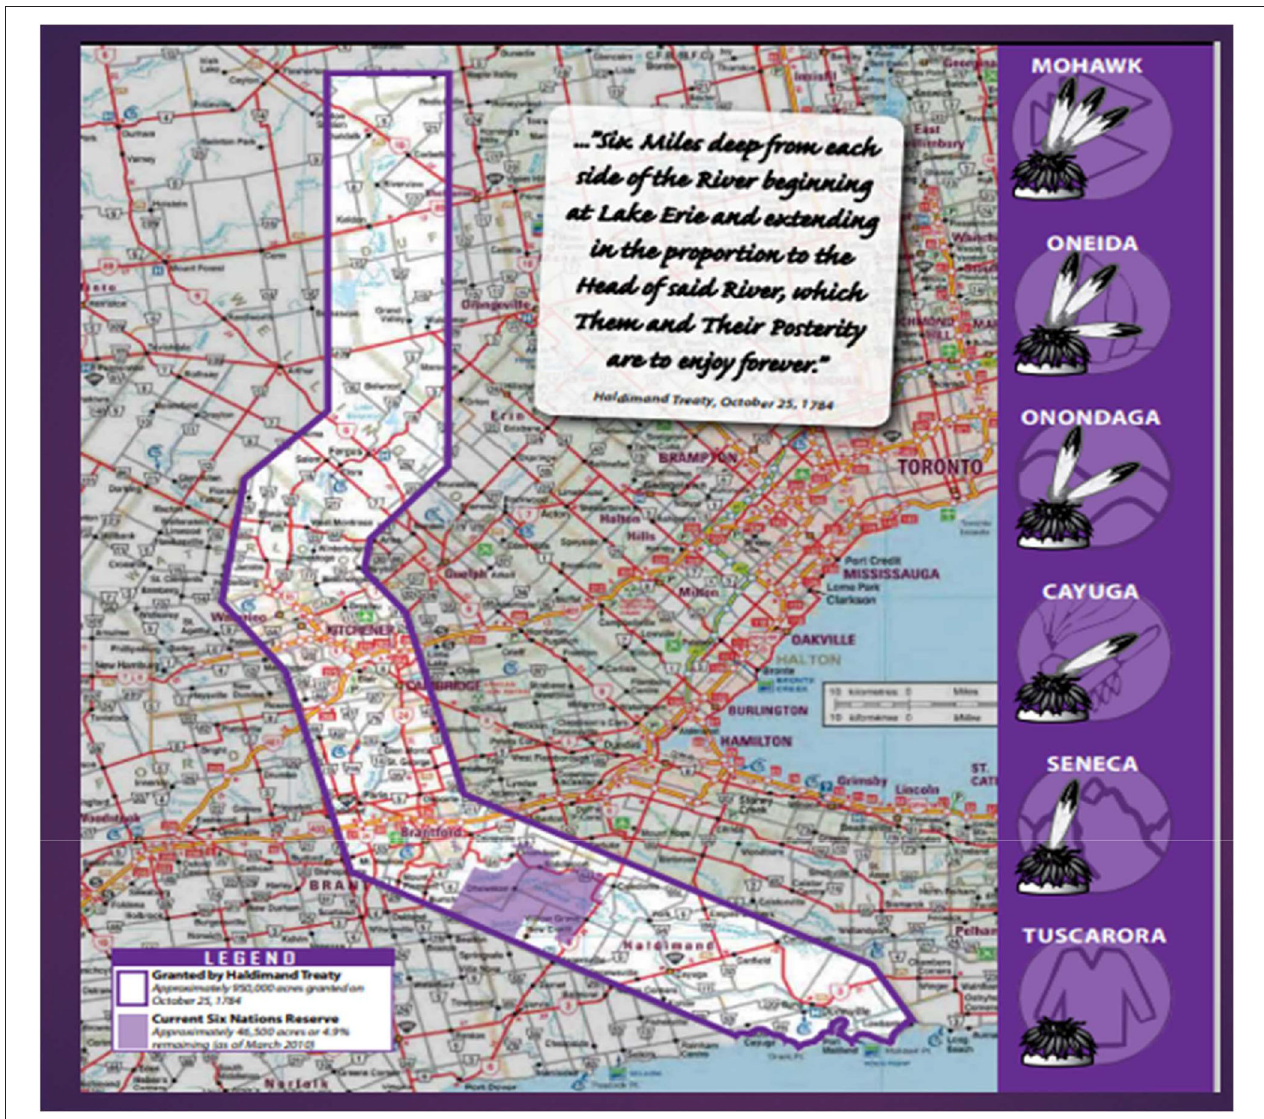
FIGURE 1 | The haldimand tract and six nations reserve. Used with permission from the Six Nations Land and Resources. (https://www.sixnations.ca/department/